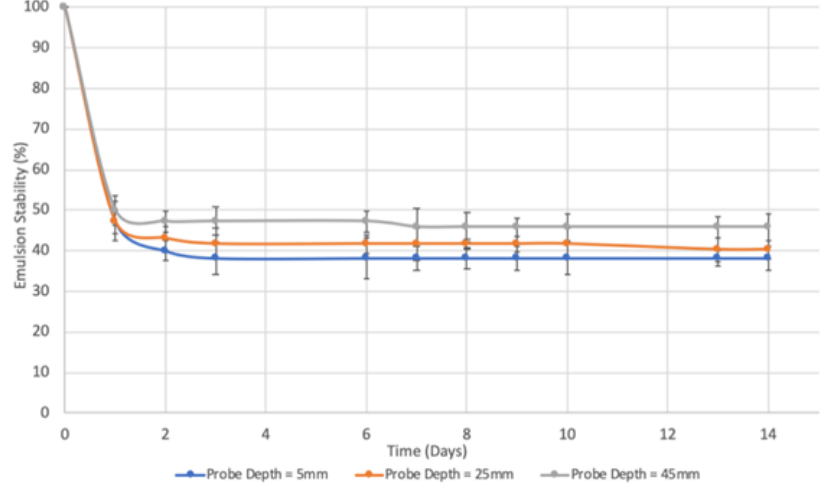
Figure 10. Emulsion stability vs. time: effects of changing the sonotrode depth.